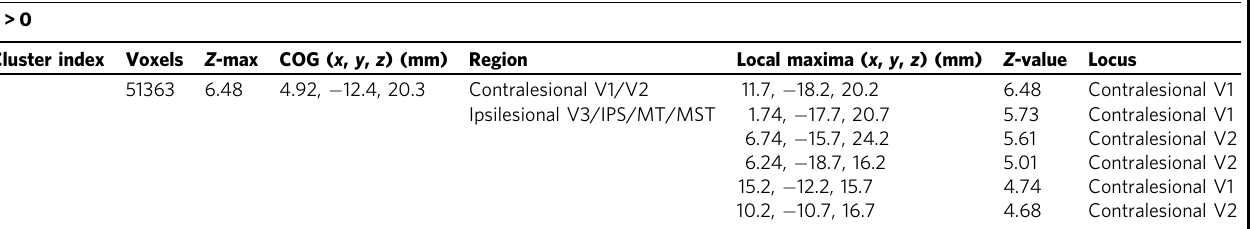
Table 2 Whole-brain statistical analysis of rCBF changes related to task condition: post-lesion period. Post-lesion